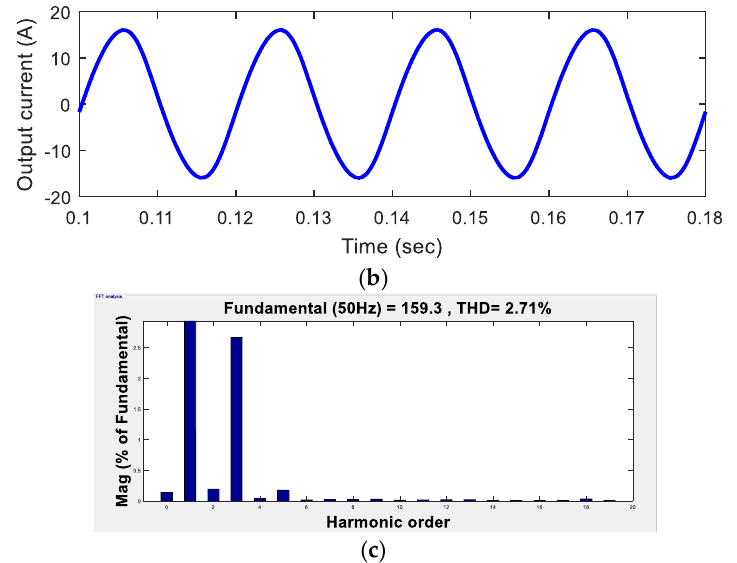
Figure 5. Input voltage at 90 V and load at 10 Ω for CUK-based ZSI ( a ) load voltage; ( b ) load current; ( c ) FFT analysis.